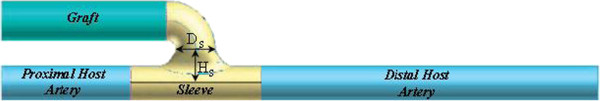
Cuff-like sleeve. Schematic view of a distal ETS anastomosis with an incorporated sleeve. Sleeve models with higher necks were deemed preferred in terms of hemodynamics at the distal anastomosis (taken from [161] with permission).